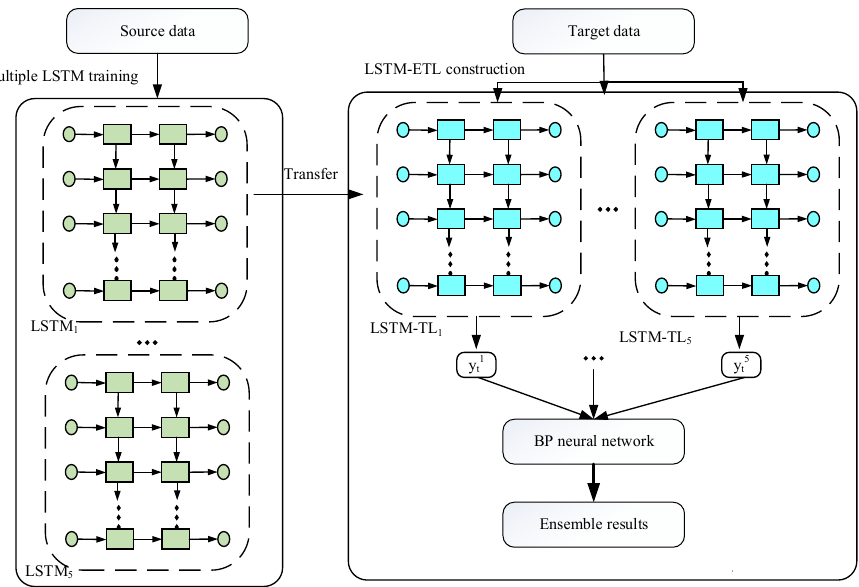
Figure 6. Construction of the proposed LSTM-ETL mode.